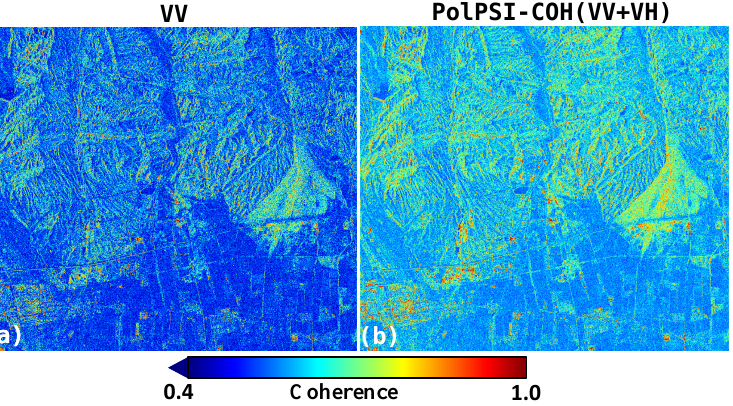
Figure 9. ( a , b ) shows the temporal average coherence of VV channel and the PolPSI-COH ap- proach,